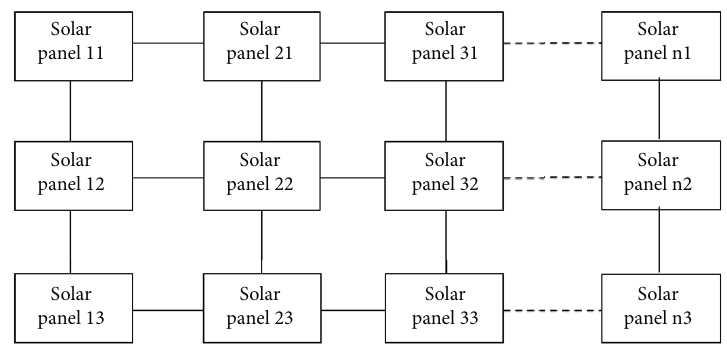
Figure 2: Photovoltaic solar power generation.